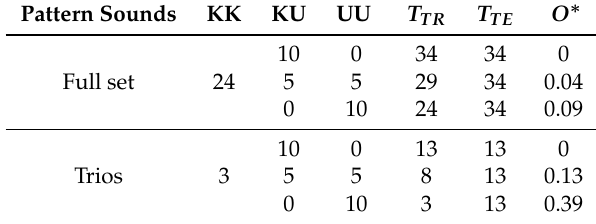
Table 2. Number of classes of each configuration and the corresponding openness value. Pattern Sounds KK KU UU T TR T TE O ∗ 10 Full set 24